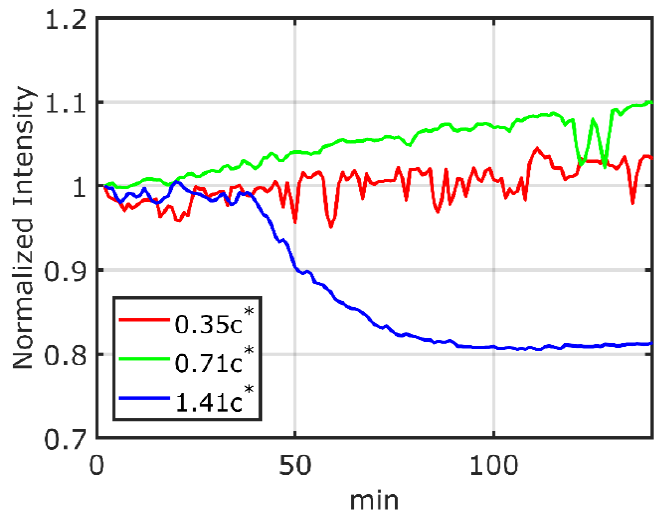
Figure 7. The time variations of the normalized fluorescence intensities of FRET molecules in polymer solutions with concentrations of 0.35 c ∗ , 0.71 c ∗ , and 1.41 c ∗ at a shear rate of 333 s − 1